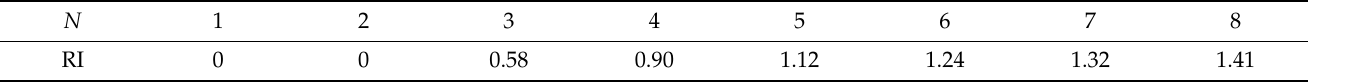
Table 3. Random consistency index values (RI) adapted from